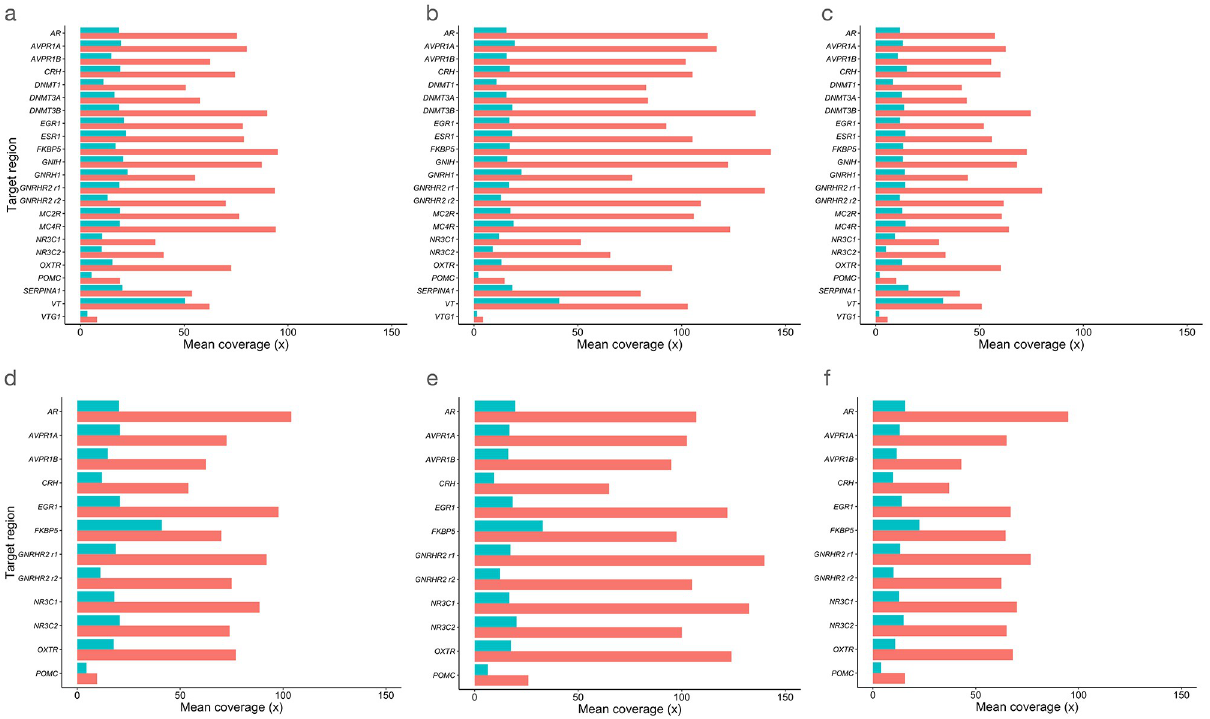
Fig 2. Comparison of mean target region coverage (after deduplication) for target-enriched enzymatic methyl sequencing (TEEM-Seq) and whole- genome enzymatic methyl sequencing (WGEM-Seq) in ( a - c ) putative promoter and ( d - f )exonic regions. Libraries for three of the same individual superb starlings ( a and d ) BB-17168, ( b and e ) BB-17501, and ( c and f ) BB-14232 were sequenced using TEEM-Seq (red bars) and WGEM-Seq (blue